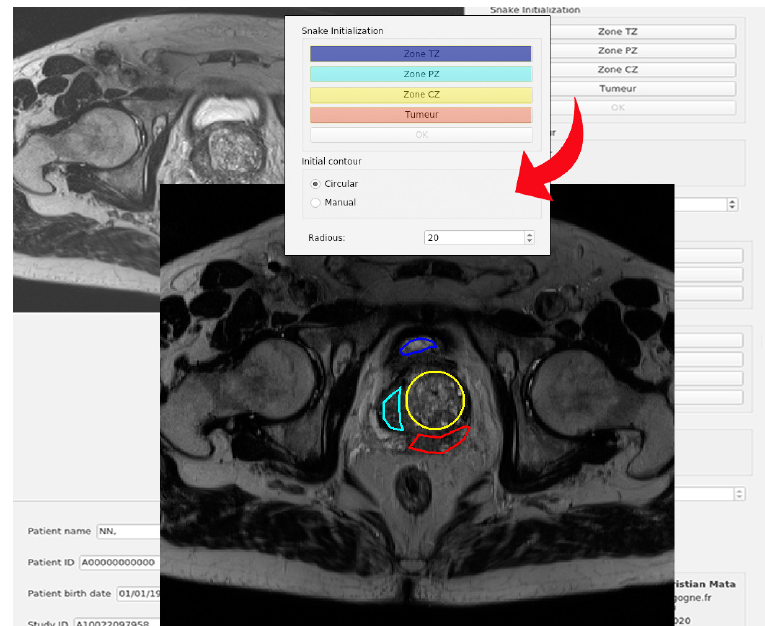
Figure 8. Example of snake initialization for the four